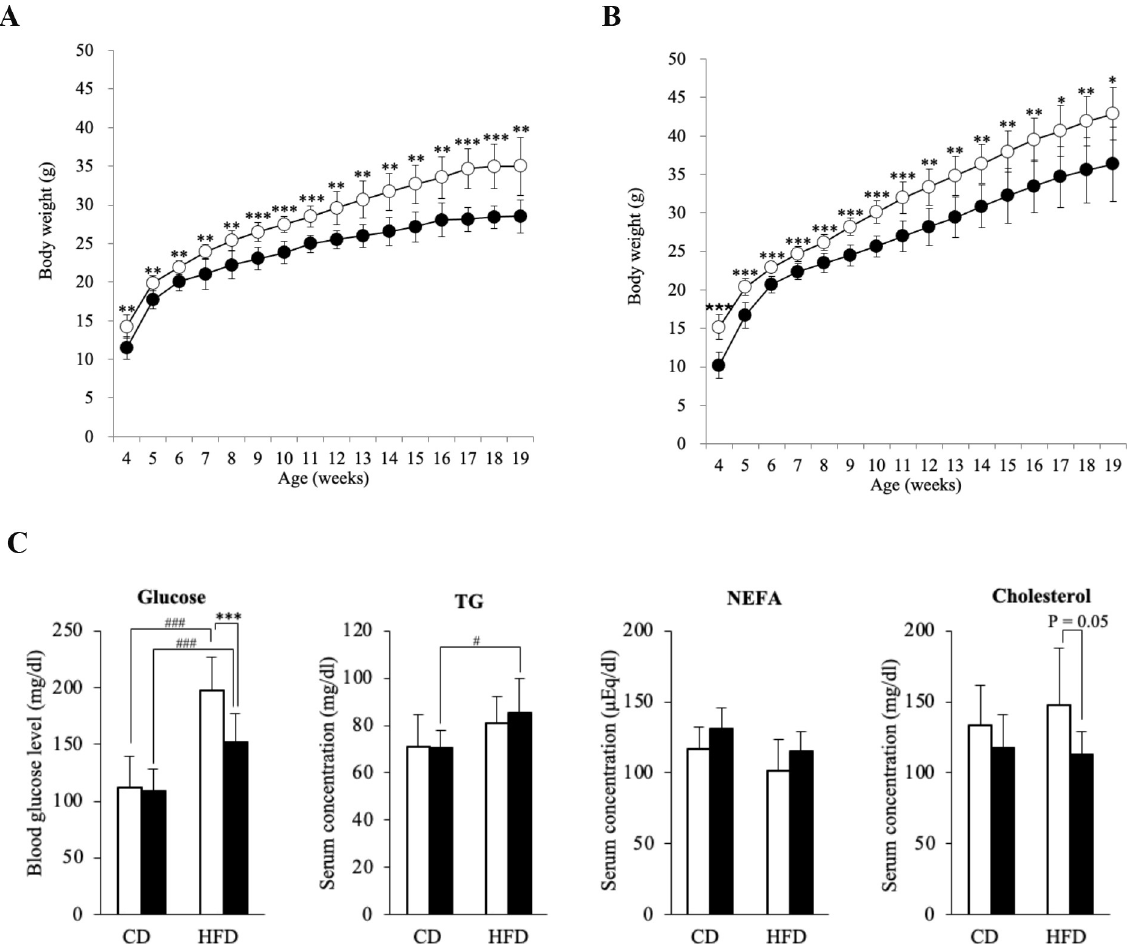
Fig 2. DKO mice showed milder phenotypes in HFD-induced body weight gain and hyperglycemia. ( A ) Body weights of WT and DKO mice in CD-fed states (WT, n = 7; DKO, n = 6), and ( B ) HDF-fed states (7 mice each). Body weights recorded every week from 4 to 19 weeks old. Open and closed bars indicate WT and DKO mice, respectively. Data are expressed as means ± S.D. � P < 0.05, �� P < 0.01, and ��� P < 0.001 as compared between WT and DKO mice. ( C ) Blood glucose and serum levels of lipids in CD-fed or HFD-fed mice. Open and closed bars show WT and DKO mice, respectively. Data are expressed as means ± S.D. ��� P < 0.001 as compared between WT and DKO mice. # P < 0.05 and ### P < 0.001 as compared between CD and HFD